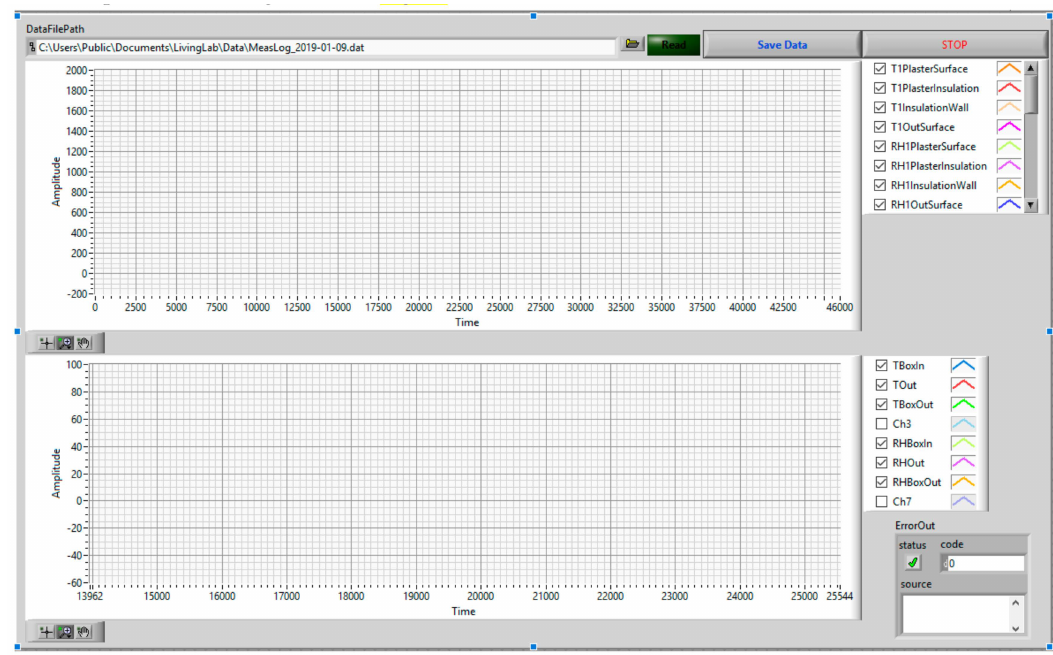
Figure 12. The front panel of the software developed to analyze data o ff